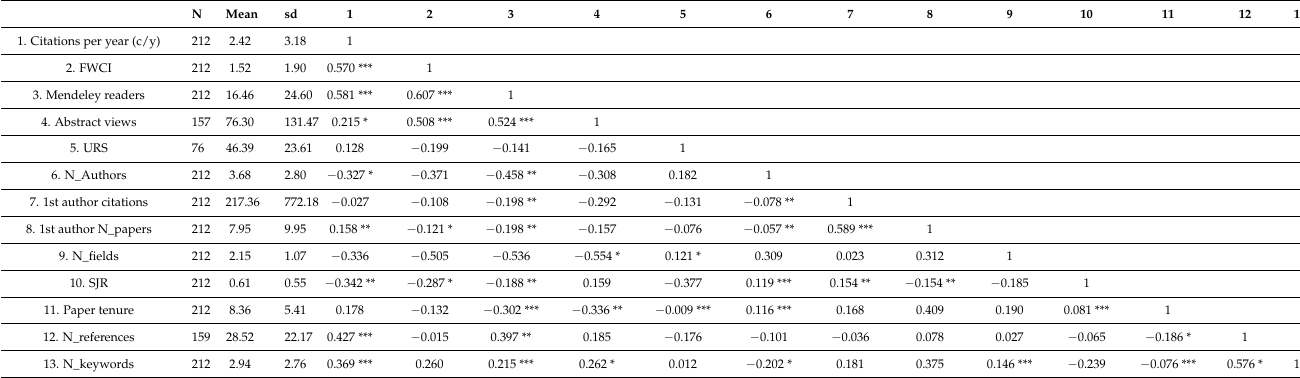
Table 1. Descriptive data and correlation matrix of the numeric